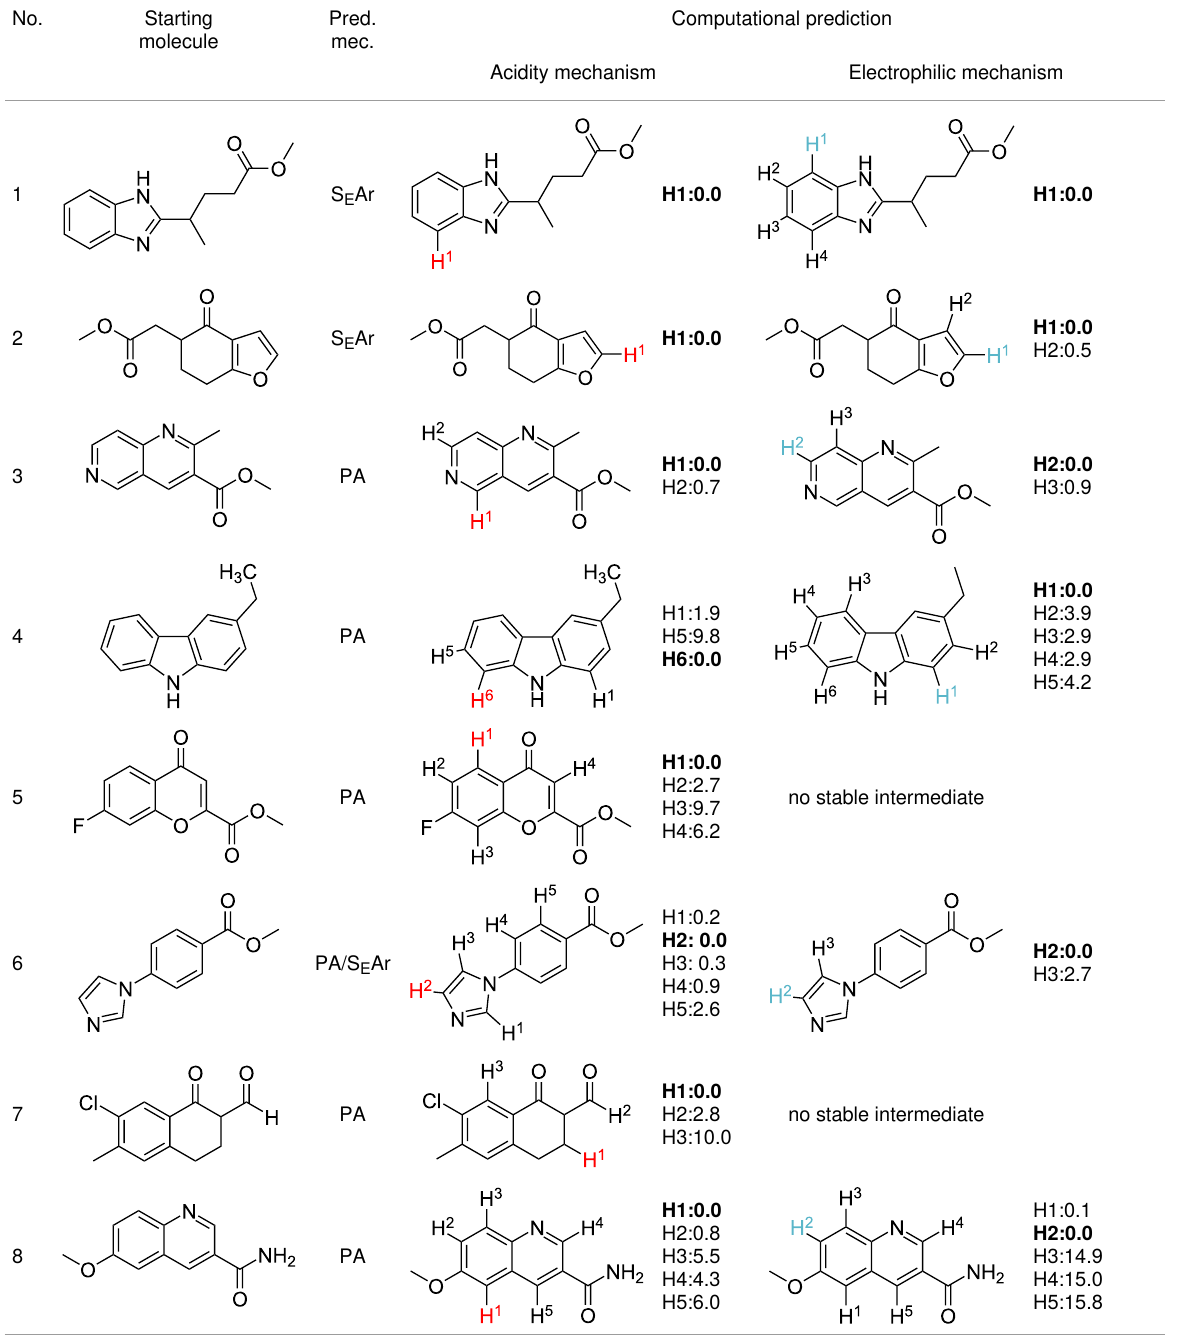
Table 2: Predicting C–H activation bond for heteroaromatic compounds. a